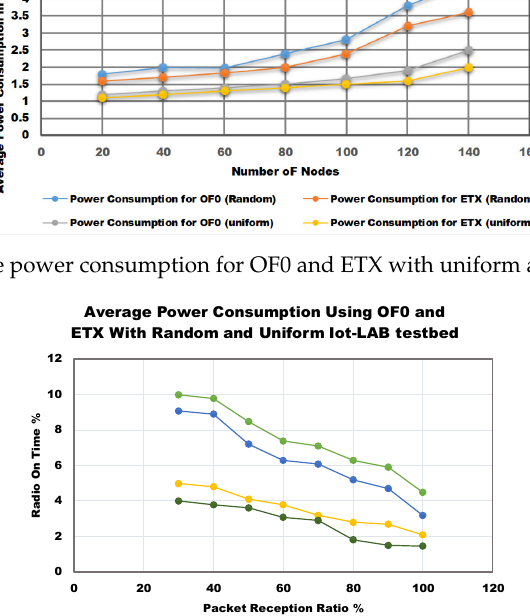
Figure 14. The average power consumption in terms of radio on time for OF0 and ETX with uniform and.